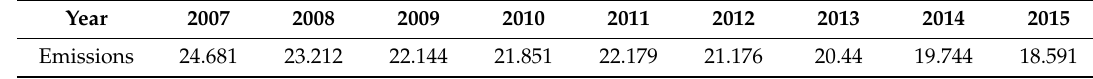
Table 1. China’s sulfur dioxide emissions (unit: million